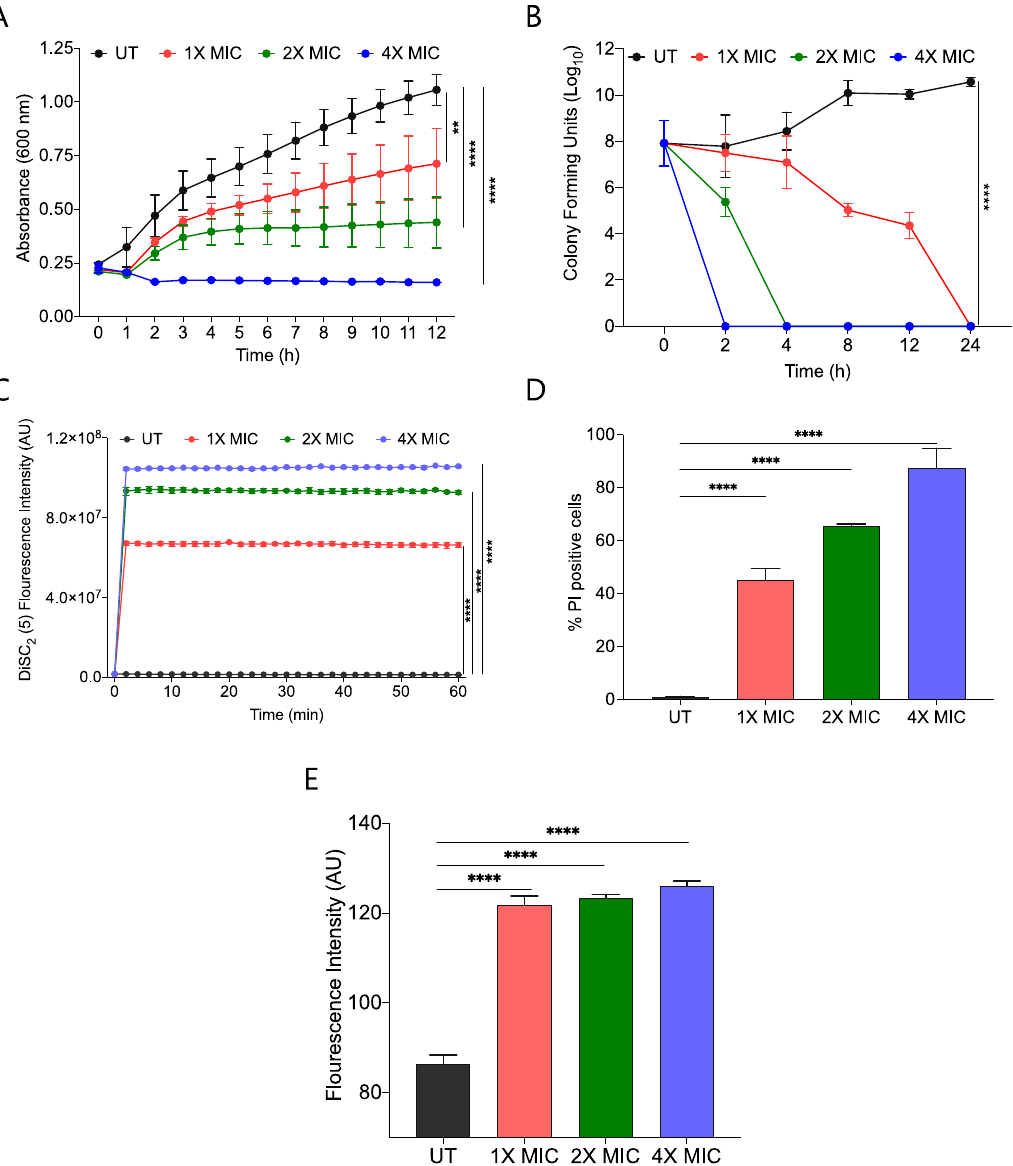
Figure 3. ( A ) Growth kinetic studies of S. aureus in presence of CABI- 6 confirm the dose-dependent antibacterial potency of CABI- 6 . ( B ) Time-kill kinetics showing dose-dependent bactericidal activity of CABI- 6 against S. aureus . ( C ) Fluorescence-based assay displaying the membrane permeabilizing property of CABI- 6 against S. aureus . ( D ) Dose-dependent percentage increase in the number of propidium iodide (PI)-positive bacterial cells endorse the membrane disruptive property of CABI- 6 . ( E ) Fluorescence-based assay confirms bactericidal activity by increasing the production of reactive oxygen species. Data were analysed by ANOVA (**** p <0.0001; ** p <0.001).